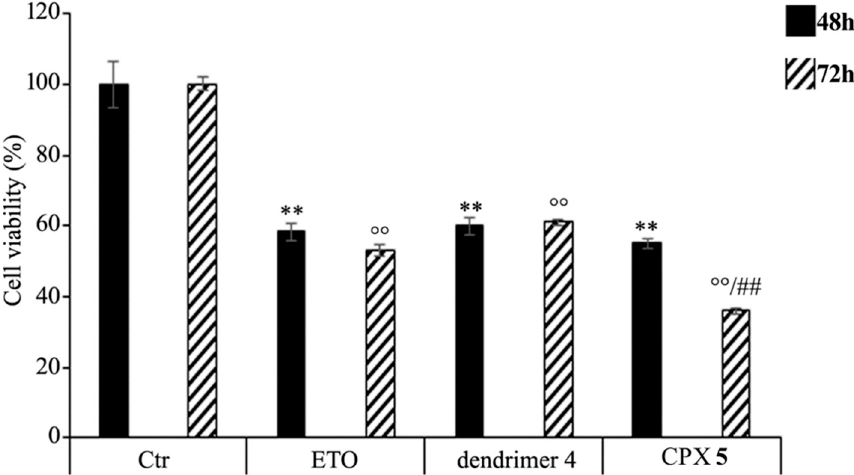
Figure 7. Cell viability was evaluated by CellTiter 96 ® AQueous One Solution Cell Proliferation Assay in NB cells exposed to ETO (1.25 µ M), CPX 5 (in a dose able of providing 1.25 µ M ETO, and dendrimer 4 (at the same dose of CPX 5 ) for 48 and 72 h. Histograms summarize quantitative data of the means ± S.E.M. of three independent experiments. ** p < 0.01 vs. Ctr cells (48 h); ◦◦ p < 0.01 vs. Ctr cells (72 h); ## p < 0.01 vs. ETO-treated cells (72 h).